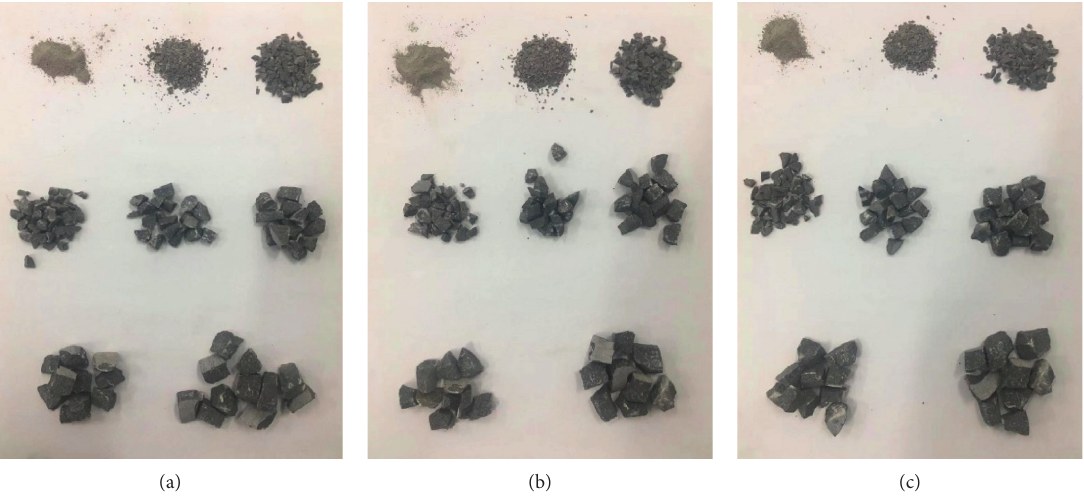
Figure 9: Sieving results of fragmentation in sandstone. (a) 4MPa. (b) 7MPa. (c) 10MPa. Table 5: Mass fractions of fragments at different scales in coal and sandstone samples under different initial unloading confining pressures. Confining pressure (MPa) Scale (mm) Coal